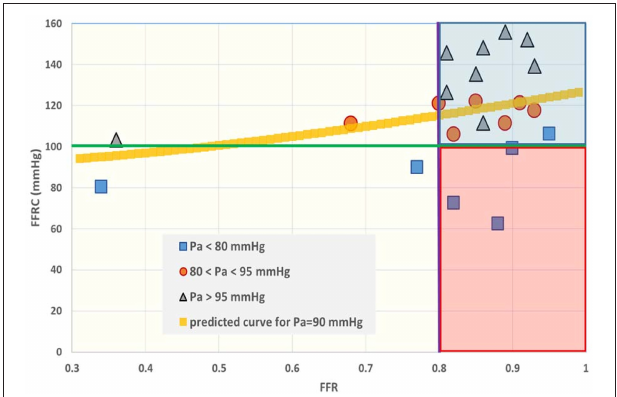
FIGURE 6 | Fractional flow reserve ( FFR ) and the intrinsic companion ( FFR C ). The interpretation of FFR is not unique, as a large spread of the co-metric FFR C can be discerned. In the past the region between 0.75 and 0.80 was termed the “gray zone.” Data points having FFR > 0.80 (purple line) are often considered to refer to patients who do not require revascularization. However, the situation becomes different if the FFR companion ( FFR C ) is accepted as a second criterion. When, for example, the green line is taken as an additive cut-off level, then the data located in the red shaded area do not simultaneously fulfill both criteria. Obviously, establishment of combined cut-off levels requires robust evaluation in large patient groups. The yellow curve is FIGURE 5 | Post-stenotic pressure ( P D ) vs. mean aortic pressure ( P A ) during calculated for P A 90 mmHg on the basis of Equation (7), i.e., = hyperemia with stenosis at different anatomical locations. Data points refer to FFR 2 FFR C P A √ 1 + = 22 patients with right coronary artery (RCA) stenosis. The three symbols specify the anatomical location of each stenosis, being distal (d), medial (m), or proximal (p). The black (identity) line corresponds with a fractional flow reserve ( FFR ) of 1.00 (i.e., no stenosis). Regression line: P D 0.873 P A – 6.836, R = = 0.728, P < 0.001, N 22. In the section Discussion, this graph is compared = with Figure 4 which shows results from the in silico study.